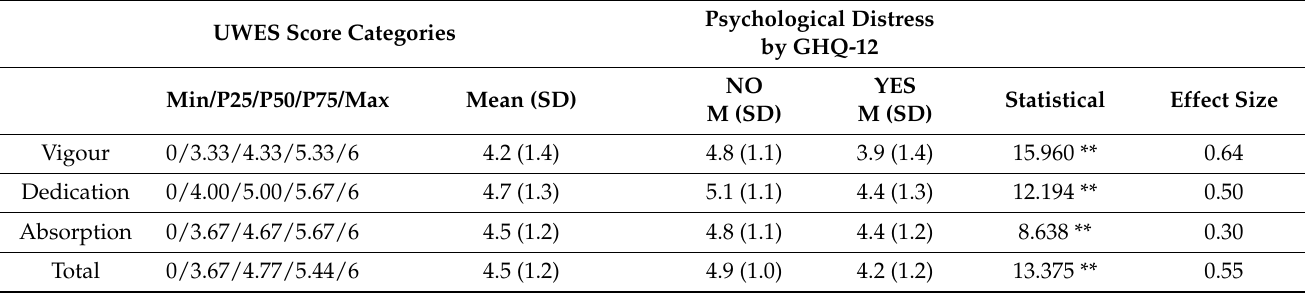
Table 4. The associations between the UWES dimensions and psychological distress ( N =